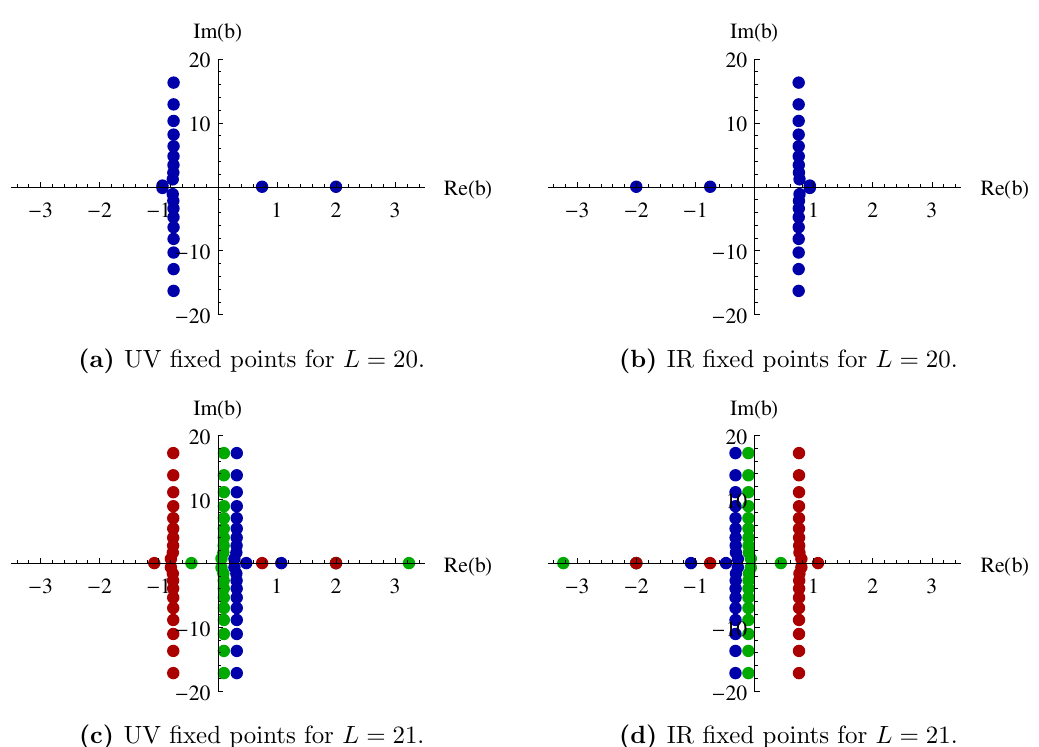
(d) IR (cid:12)xed points for L = 21. (Blue), U ; I(A)